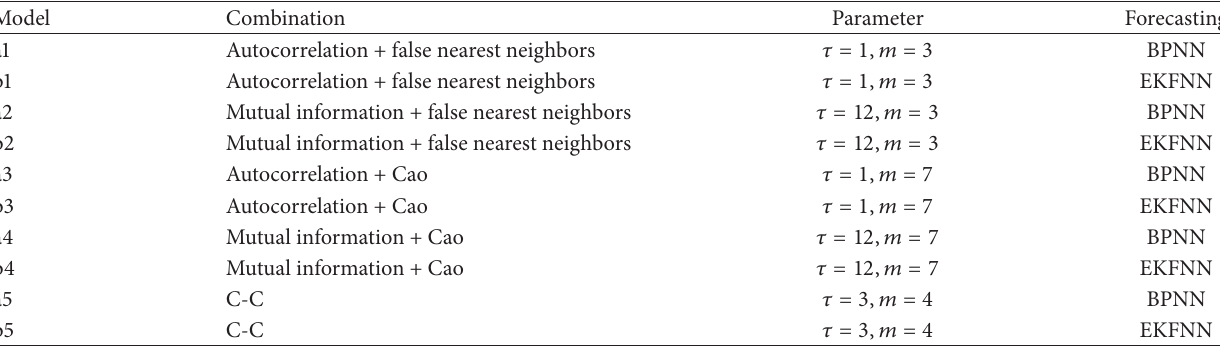
Table 5: Various combinations on two forecasting